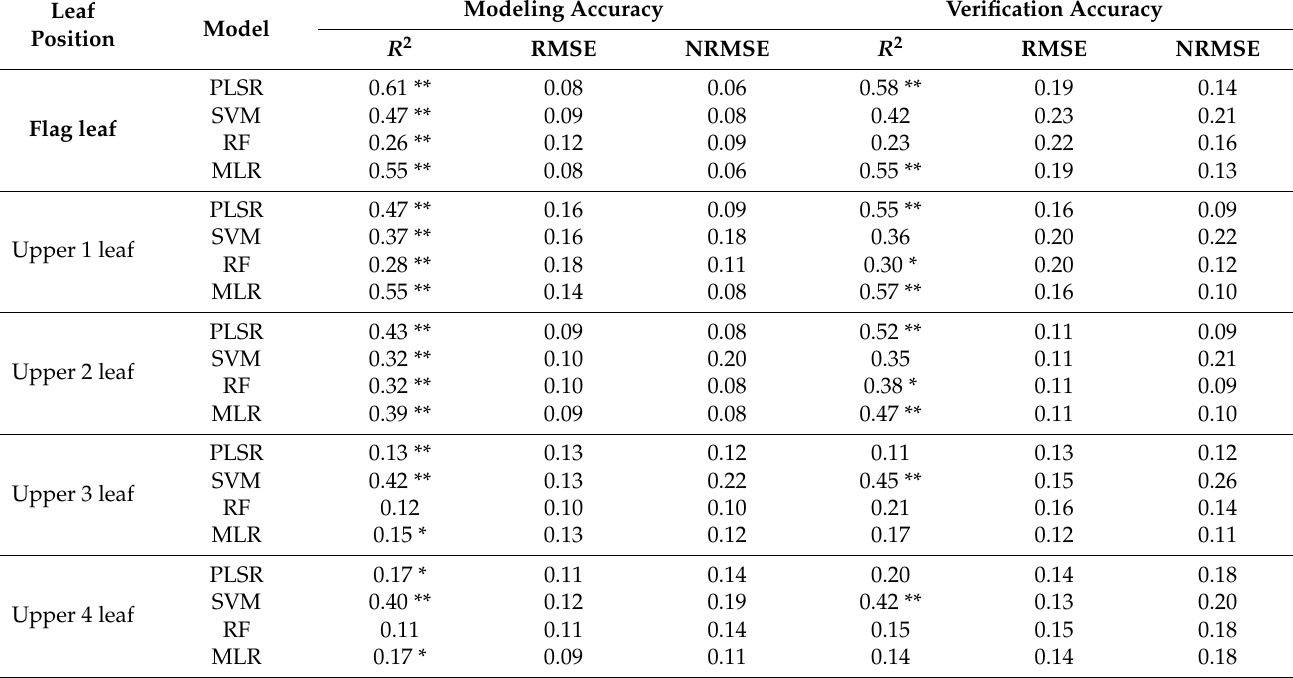
Table 3. Model accuracy of estimating leaf nitrogen content based on sensitive